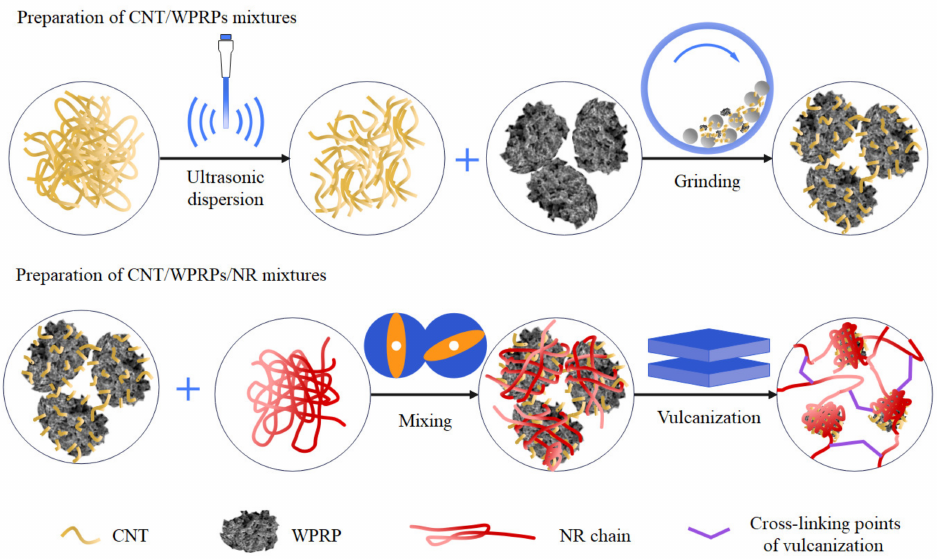
Figure 1. Ultrasonic grinding dispersion mechanism of CNT.